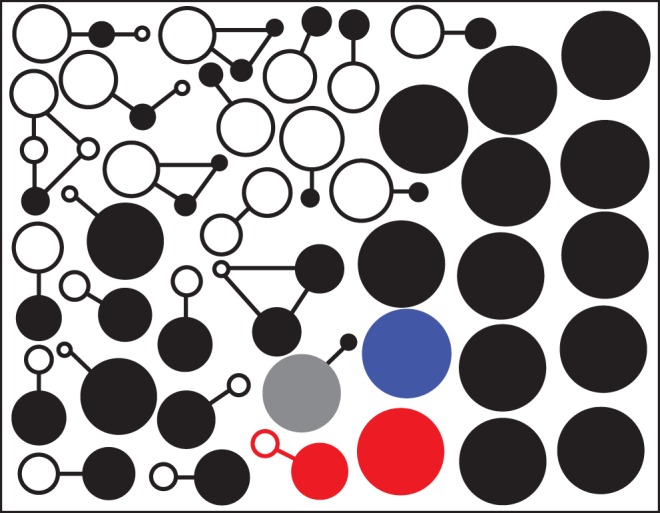
Genotypic diversity in 38 MRSA carriers. Each circle represents an MGE profile based on the presence or absence of four phages, two plasmids and the qacA gene. Connected circles are different MGE profiles from the same carrier. Circle size is proportional to MGE profile incidence in each patient and filled circles represent the MGE profile with the most phage and plasmid genes in that carrier. Black is lineage CC22, blue is lineage CC8, red is lineage CC45 and grey is lineage CC1. This figure appears in colour in the online version of JAC and in black and white in the print version of JAC.